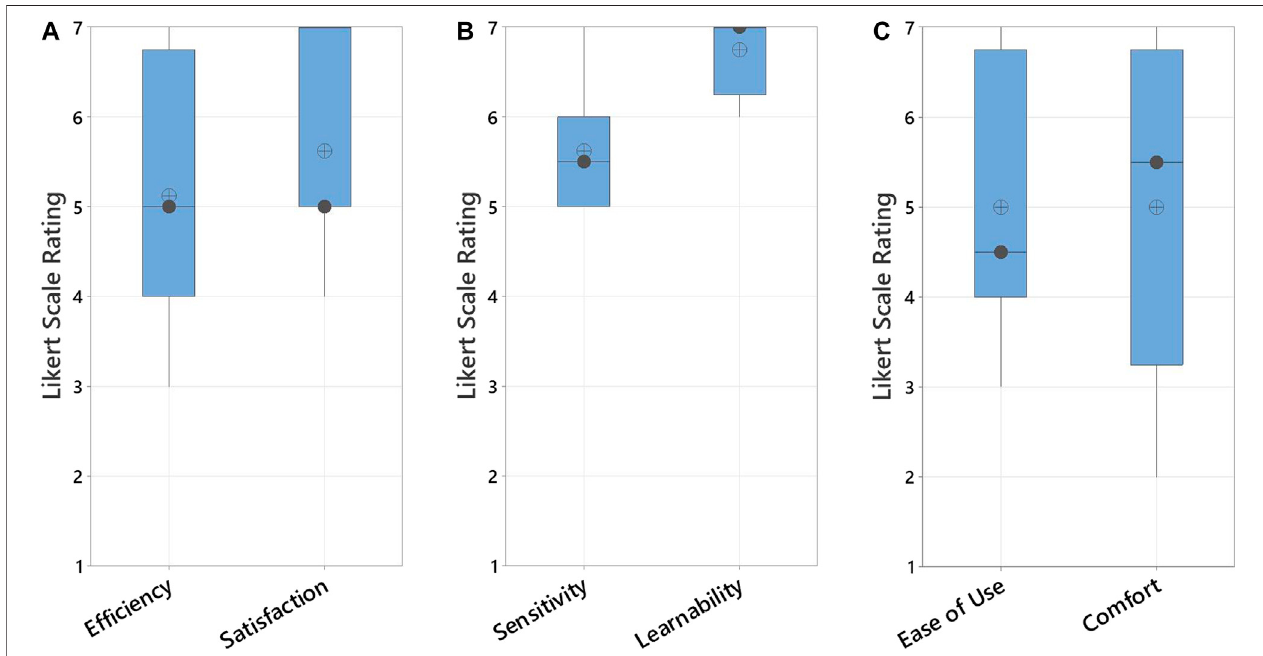
FIGURE5| Usability and User Experience ratings forour inputsystemwhen playing theFPS game. (A) Ef fi ciencyand Satisfaction ratings aspart oftheUsabilityof our input system for playing the FPS game. (B) Sensitivity and Learnability ratings for our input system as part of User Experience. (C) Ease of Use and Comfort ratings when playing the FPS game with our input system as part of User